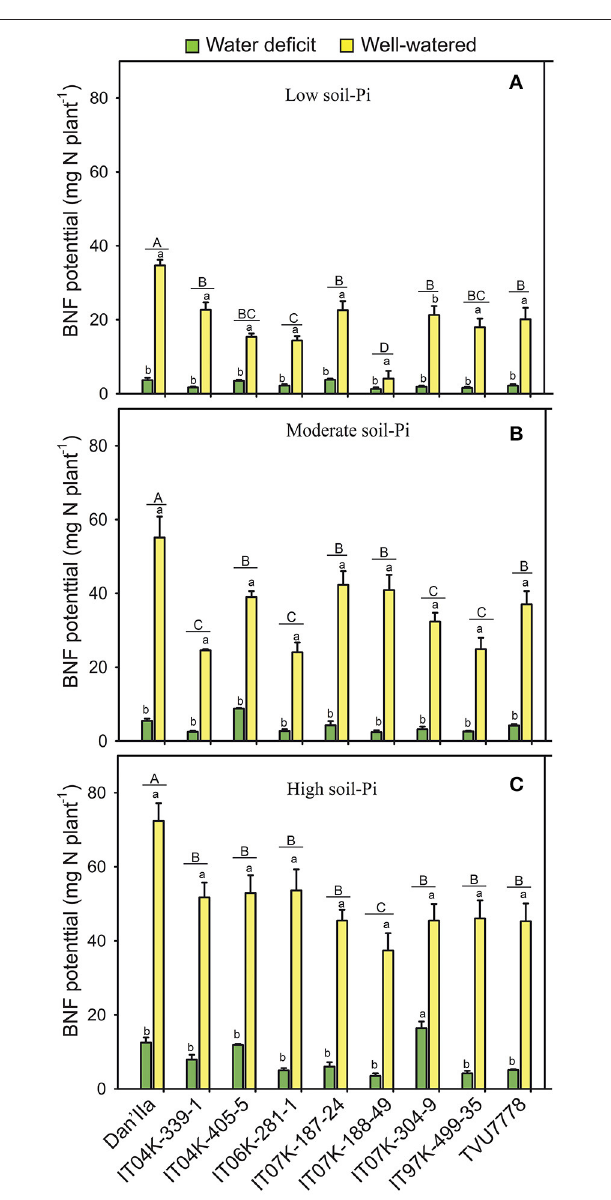
FIGURE 3 | Biological nitrogen fixation (BNF) potential in cowpea varieties under different available soil-phosphate (Pi) levels with or without water deficit stress. (A) Low soil-Pi, (B) moderate soil-Pi, and (C) high soil-Pi. Mean values and standard errors (bars) are shown ( n = 4). Different small letters indicate significant differences between the water-deficit and well-watered plants for each variety at each available soil-Pi level (Fisher’s test; p < 0.05). Different capital letters indicate significant differences among the varieties at each available soil-Pi level (Fisher’s test; p <